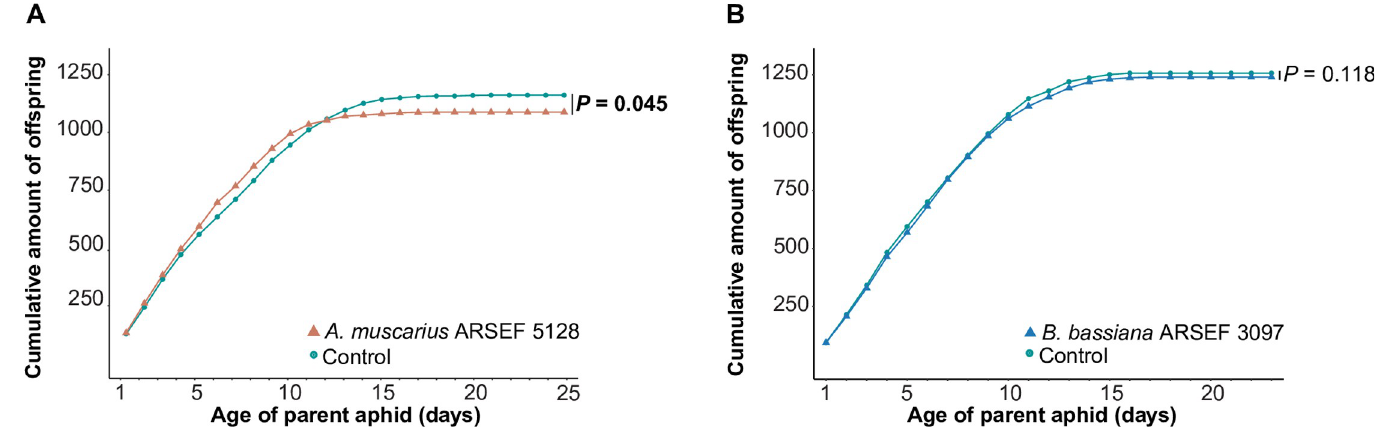
Fig 4. Cumulative number of offspring produced by apterous Myzus persicae var. nicotianae when fed on sweet pepper plants inoculated with Akanthomyces muscarius ARSEF 5128 (orange) (A) or Beauveria bassiana ARSEF 3097 (blue) (B), compared to control plants (green) (20 biological replicates of one adult per plant). Offspring was counted daily and removed after counting. P values refer to differences at the end of the experiment (Generalized Linear Mixed Model).